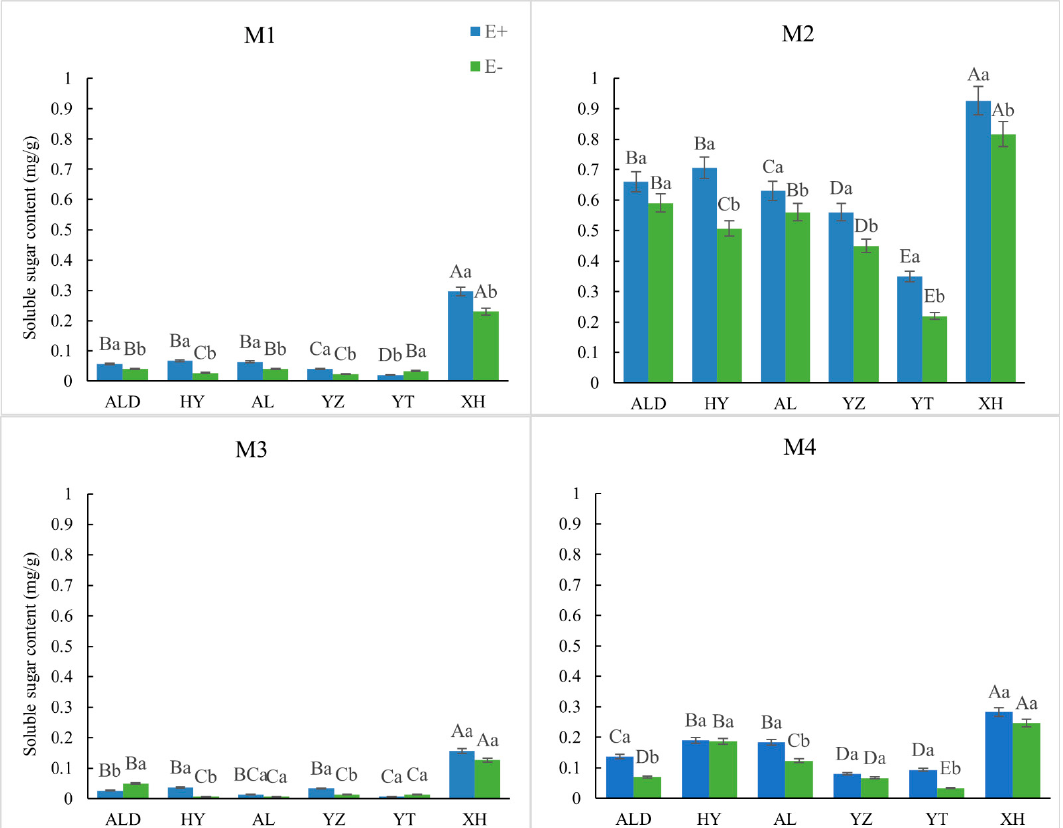
Figure 1. Relative soluble sugar content of infected (E+) and noninfected (E − ) Achnatherum inebrians from different treatments on an altitude (origin) gradient. Different capital letters indicate mean significant difference ( p < 0.05) in endophyte status (E+ or E − ) in seed germination under di ff erent origin. Di ff erent lowercase le tt ers indicate mean signi fi cant di ff erence ( p < 0.05) in pair-wise comparisons of endophyte status (E+ and E − ) in seed germination in same origin.